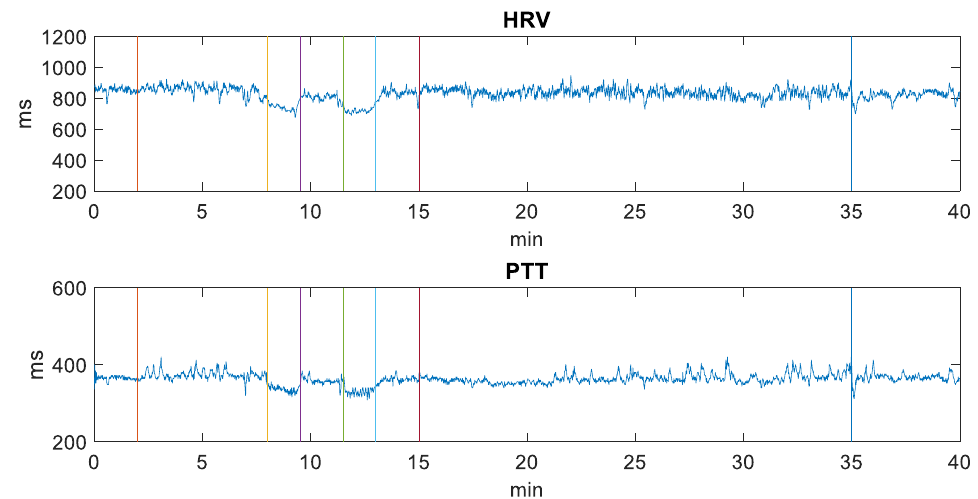
Figure 4. Variation in milliseconds of a volunteer’s HRV and PTT values throughout the experimental procedure (40 min). The vertical-colored lines separate the periods of the different activities developed during the experimentation carried out in a clinical setting with people with epilepsy.